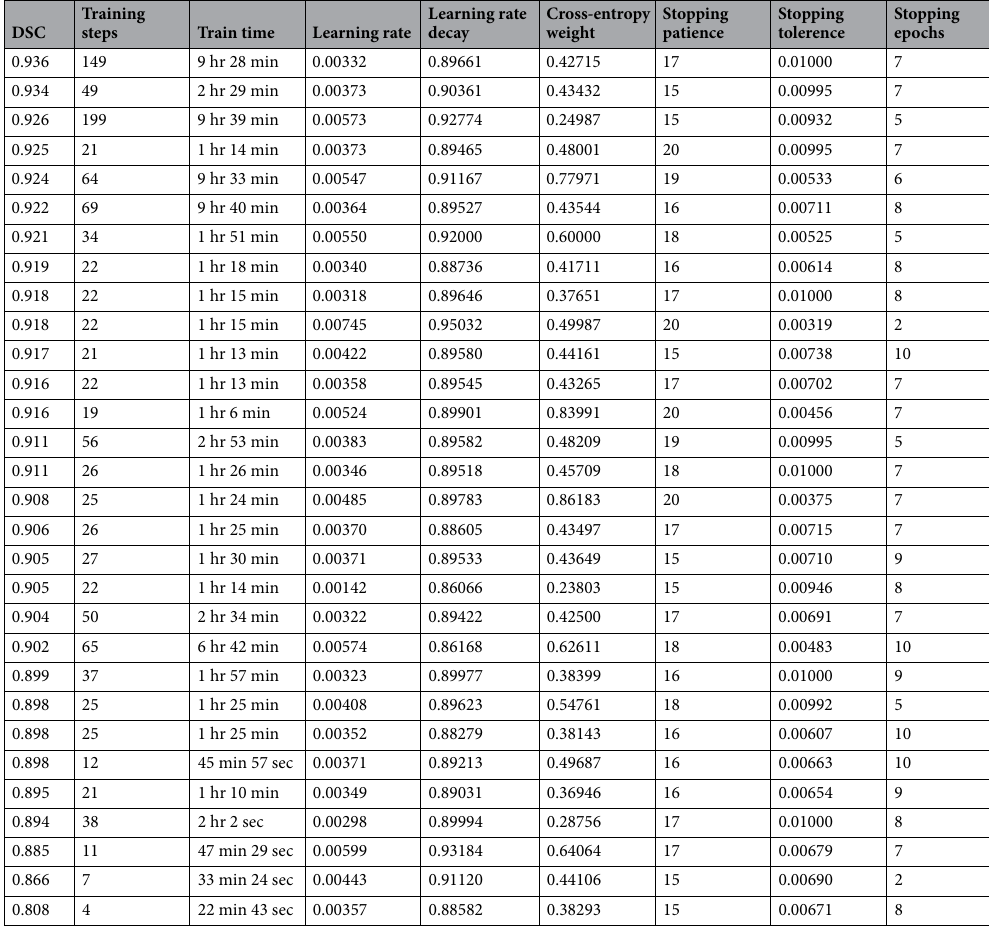
Table 4. Model performance for hyper-parameter sets tested during hyper-parameter tuning in descending order of